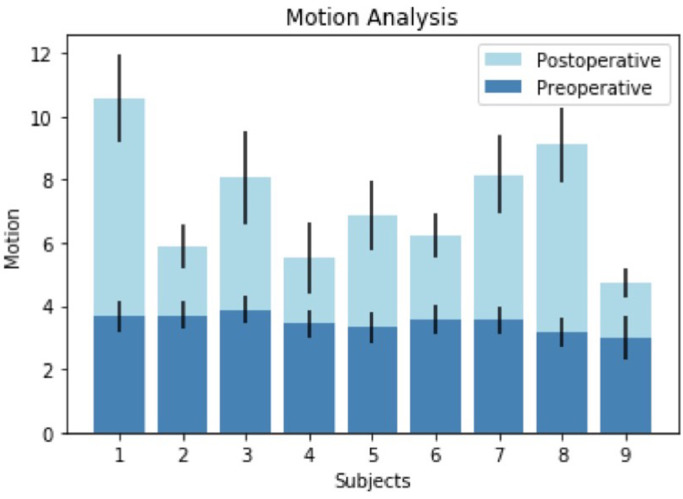
Results of the pre and post-operative motion correction analysis across subjects.